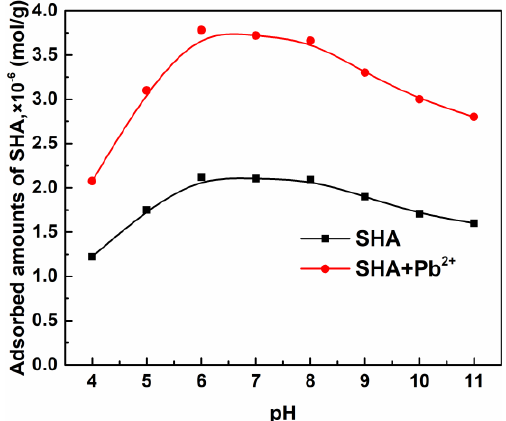
Figure 4. Effect of pH on the SHA adsorption in the absence and presence of Pb 2+ ions (C (SHA) = 2 × 10 −4 M, C (Pb 2+ ) = 1 × 10 −4 M).